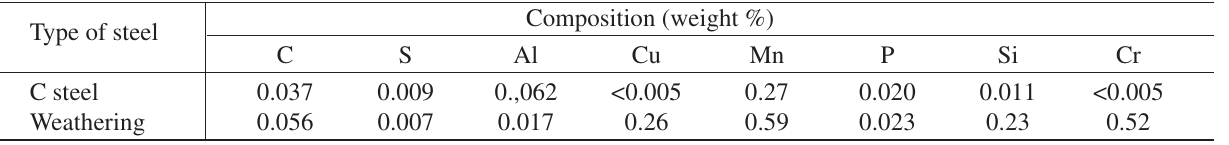
Table 1. Chemical composition of steels